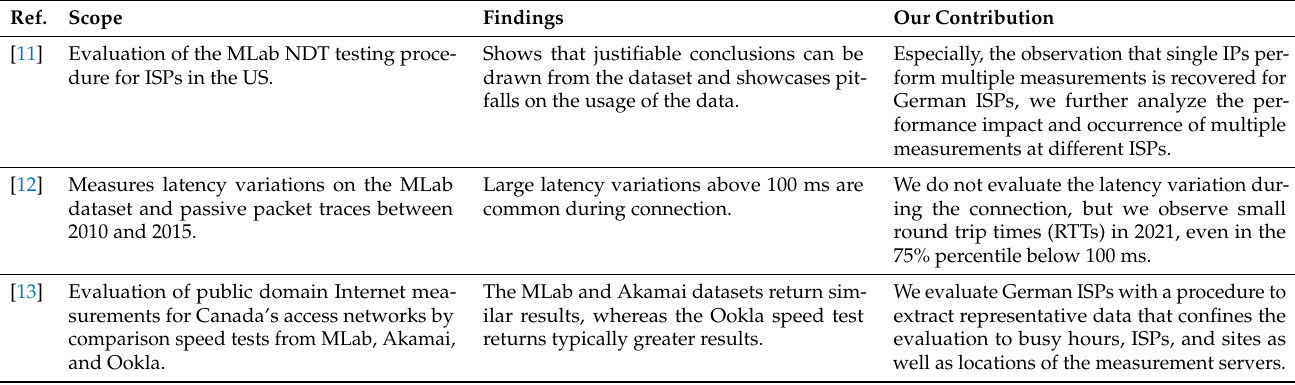
Table 1. Summary Related